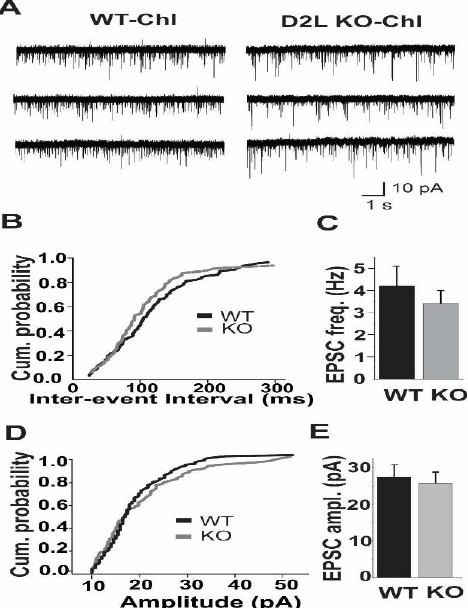
Figure 5. The frequency and amplitude of mEPSCs in ChIs were similar in WT and D2L KO mice. ( A ) Representative current traces recorded from ChIs of WT and D2L KO mice. Cumulative probability plot ( B ) and summarized bar graph ( C ) reveal there is no significant difference in mEPSC frequency between WT ( n = 6) and D2L KO mice ( n = 5) ( p > 0.08). Cumulative probability plot ( D ) and summarized bar graph ( E ) reveal there is no significant difference in mEPSC amplitude between WT and D2L KO mice ( p > 0.9). WT (Black lines or bars) and D2L KO (Grey lines or bars).